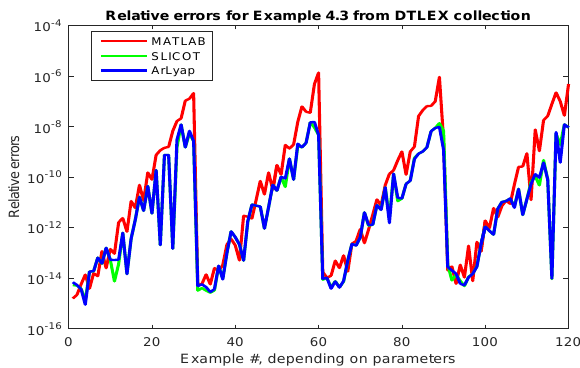
Figure 14. Relative errors for DTLEX 4.3 series of examples.